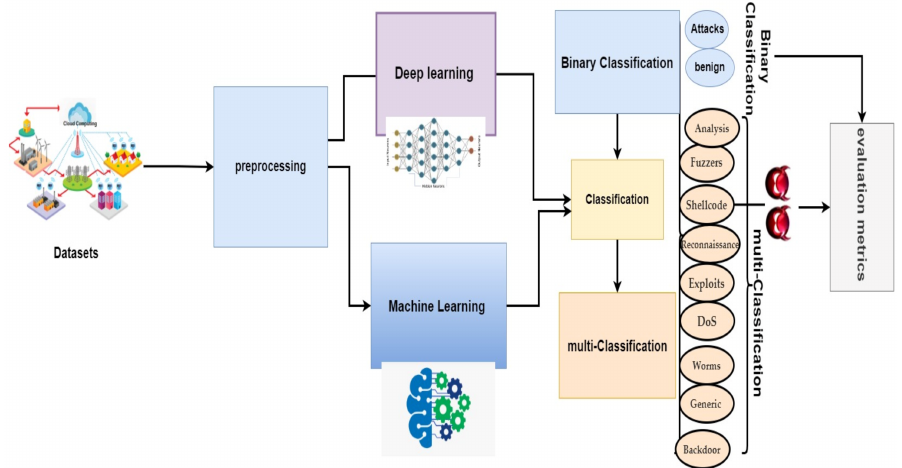
Figure 2. Framework of the proposed